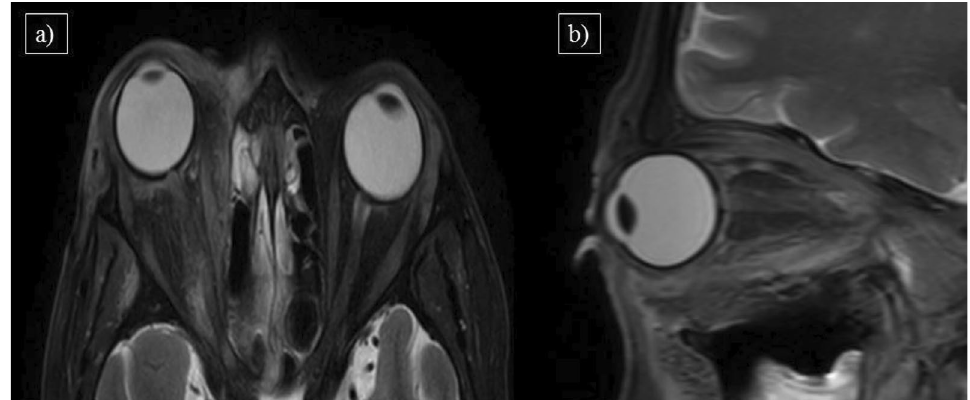
Fig. 6 a MRI Axial T2W-FS and b sagittal T2W-FS images of a 50-year-old male patient with complaints of right sided proptosis and ocular pain showing features of pre and post-septal orbital cellulitis with resultant